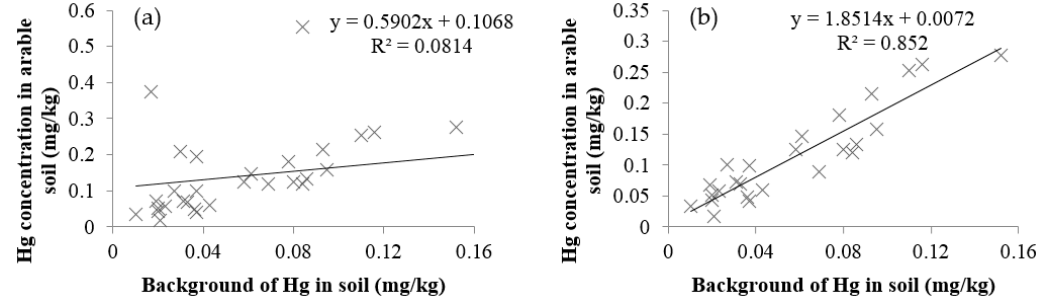
Figure 2. Scatter plots of background of Hg in soil and Hg concentration in arable soil ( a ) the whole data set; and ( b ) after removing four data pairs